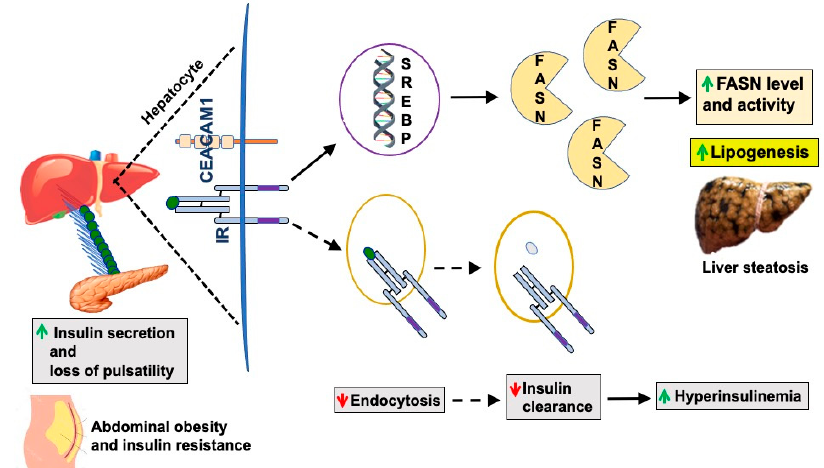
Figure 2. Elevated de novo lipogenesis in obesity. Under conditions of abdominal obesity and insulin resistance, compensatory insulin secretion increases (green upward arrow) and pulsatility of insulin release is lost. This compromises insulin signaling, endocytosis (dotted lines), and degradation (red downward arrow). The resultant reduction in insulin clearance contributes to chronic hyperinsulinemia (green upward arrow), which, in turn, activates SREBP-1c to induce FASN expression and, subsequently, lipogenesis and hepatic steatosis.